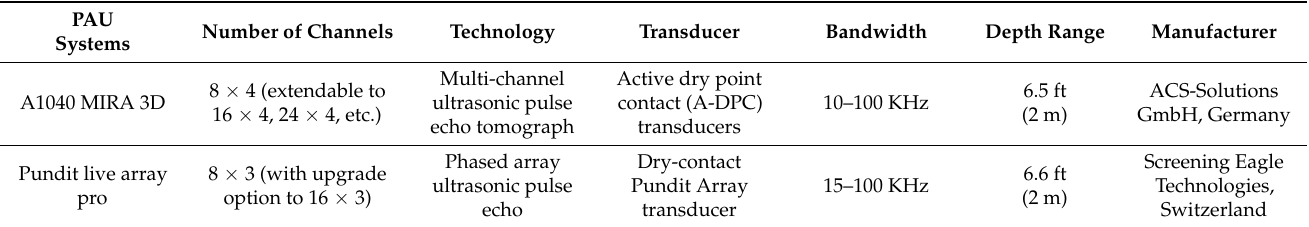
Table 4. Technical specifications of the PAU systems used [113–115].